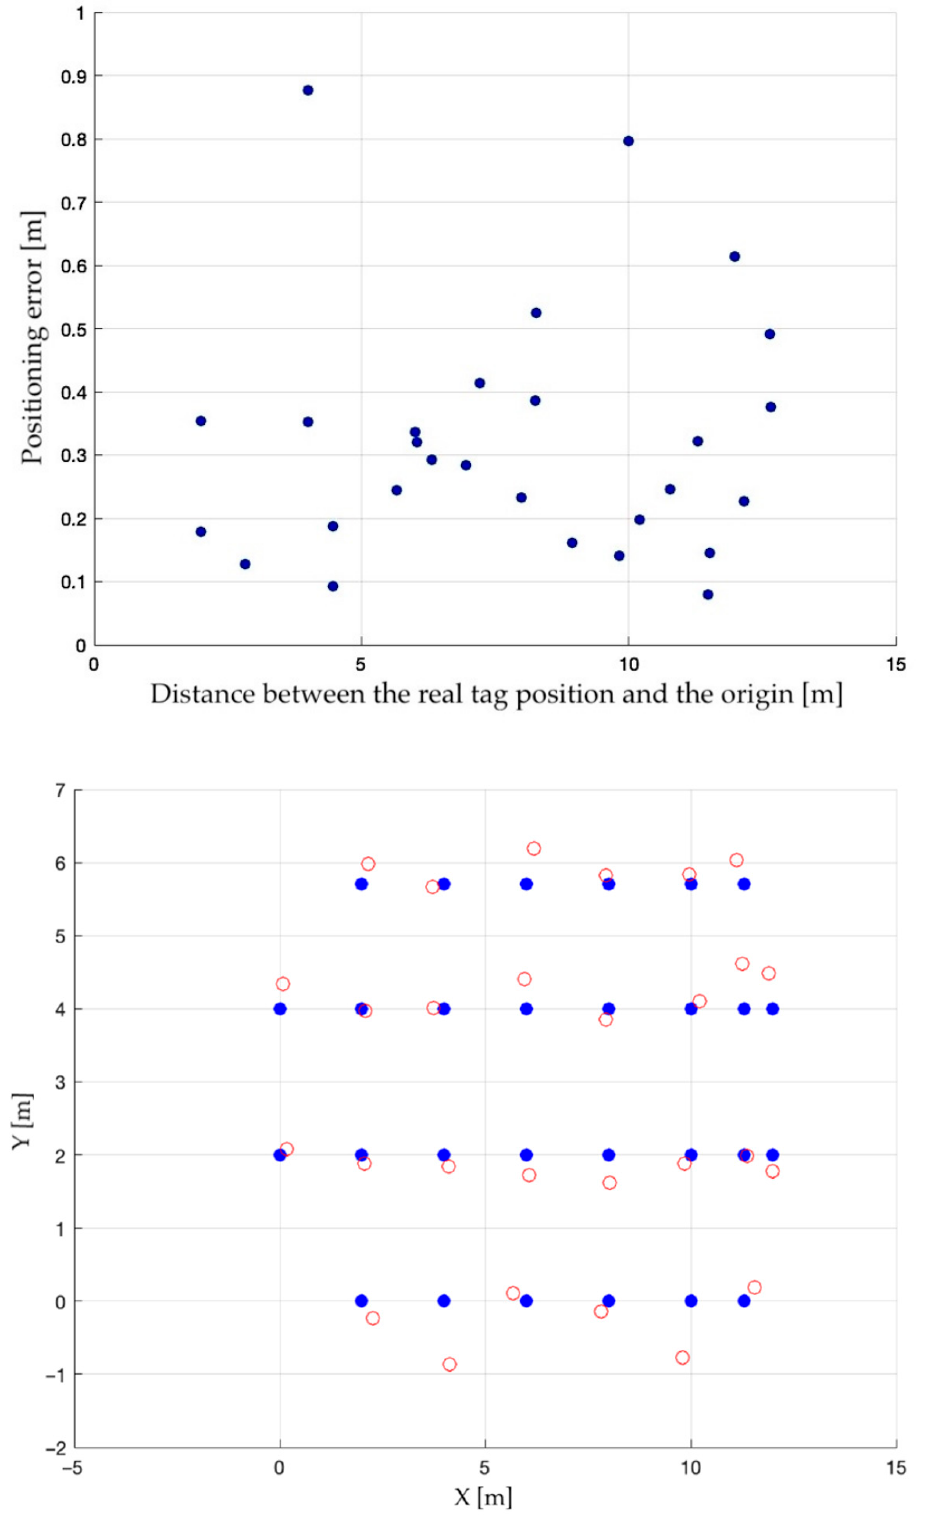
Figure 7. Average positioning error plot ( above ) and map ( below ).